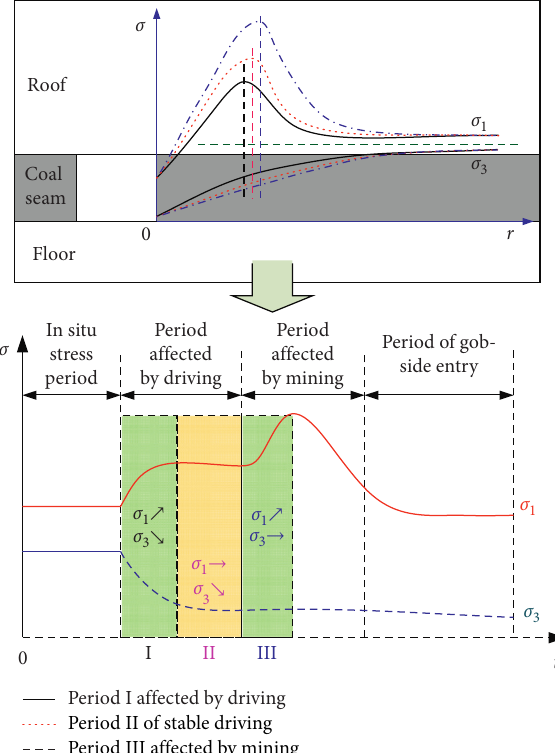
Figure 1: Conceptual model showing lateral-unloading and vertical-loading stress paths during roadway service life [1].